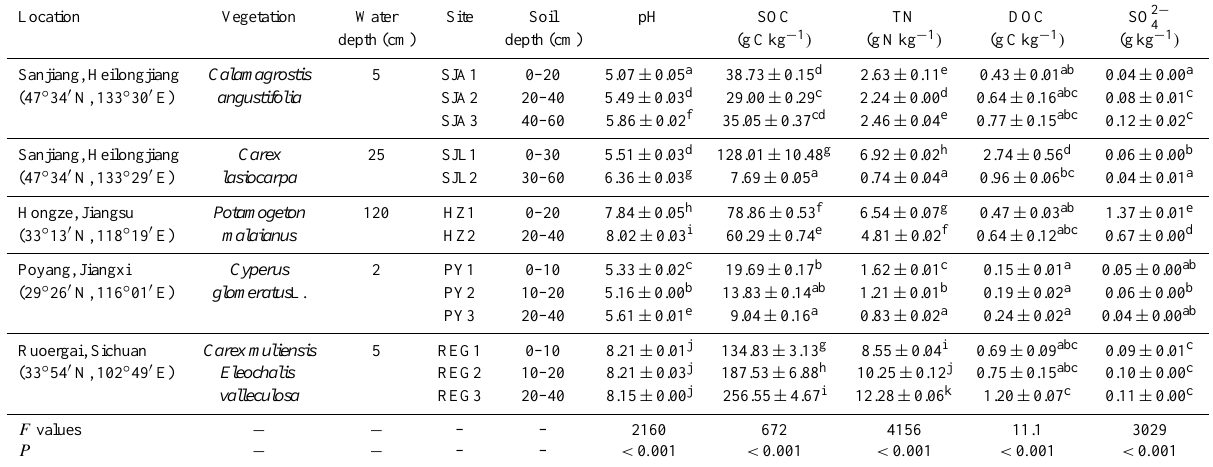
Table 1. Sampling site characteristics and soil properties.